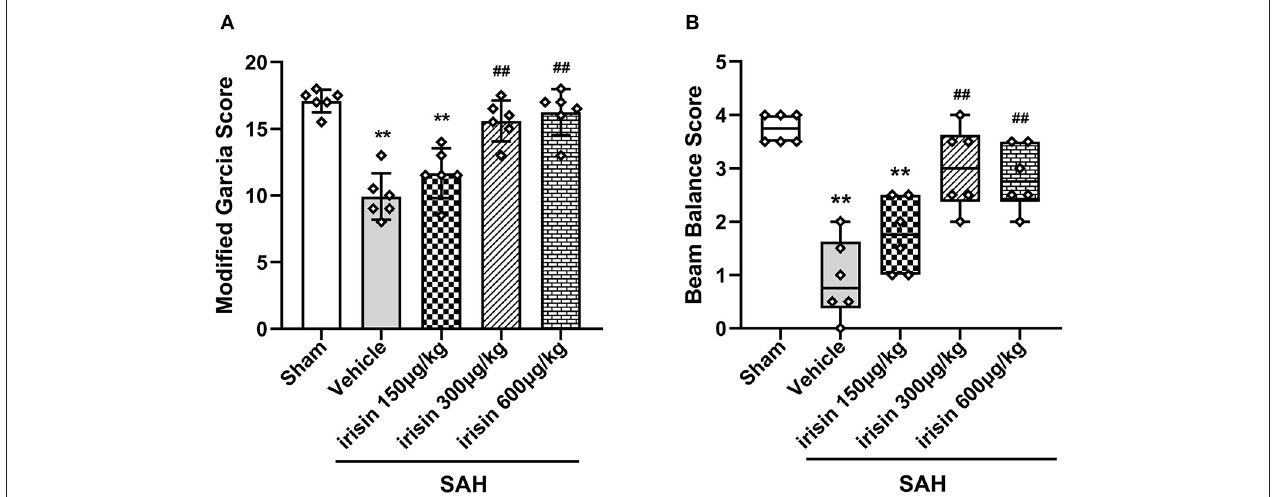
FIGURE 3 | Beneficial effects of irisin on neuronal function 24h after SAH. (A,B) Treatment with irisin significantly improved neurological deficits at 24h after SAH and 300 µ g/kg irisin was selected as the effective dose, n = 6 per group. The modified Garcia scores were represented as mean ± SD; the one-way ANOVA was used followed by the Tukey’s HSD post-hoc test and the Holm–Bonferroni correction method. The beam balance test scores were represented as median 25–75th percentiles, and the Mann–Whitney U -test and the Kruskal–Wallis test followed by the Steel–Dwass test for multiple comparisons were used to analyze the difference between groups. ** P < 0.01, ## P < 0.01 vs. SAH + Vehicle group. Vehicle group, sterile 0.9% of NaCl; SAH, subarachnoid